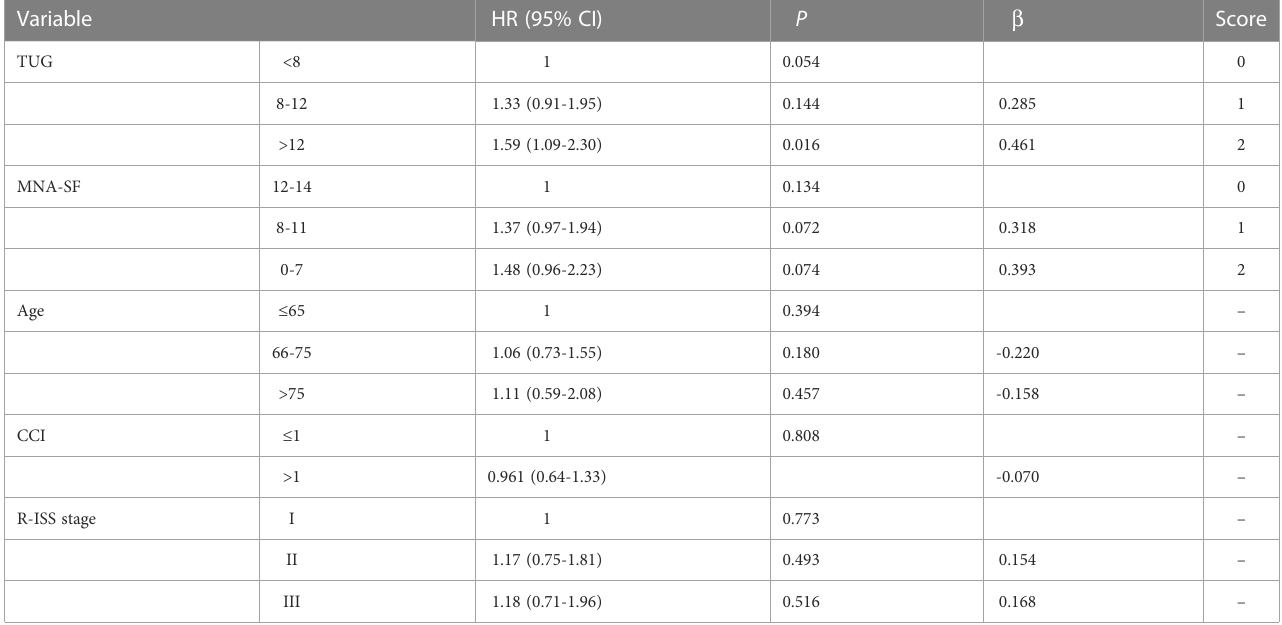
TABLE 6 Multivariate Cox proportional hazards model for grade ≥ 3 AEs.